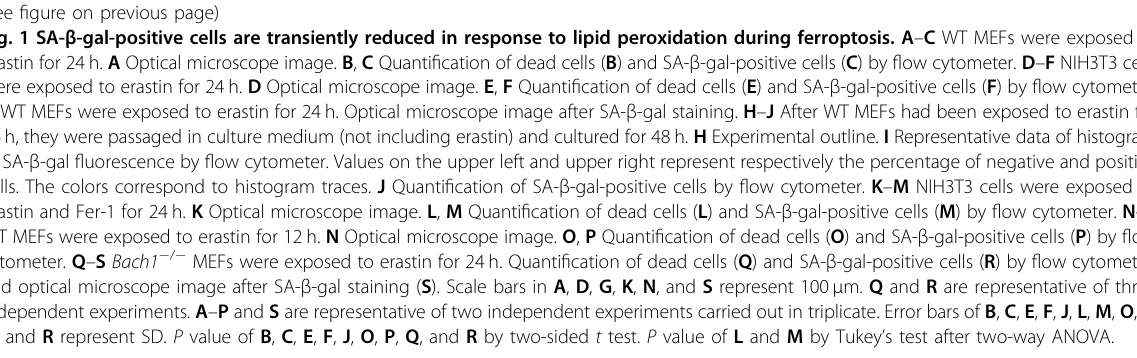
Supplementary Fig. S4B – E). The protein stability and enzymatic activity of SA- β -gal may be affected by the enhancement of autophagosome formation and lysosomal activity during ferroptosis.